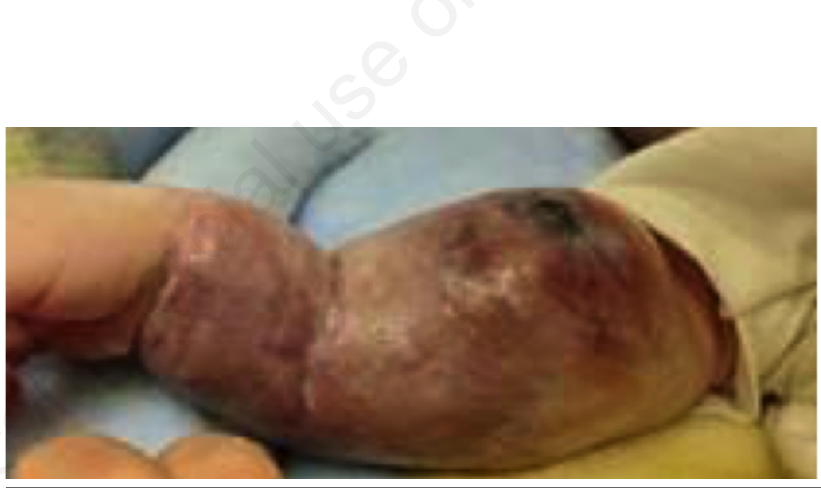
Figure 1. First clinical observation of the right arm of the newborn.